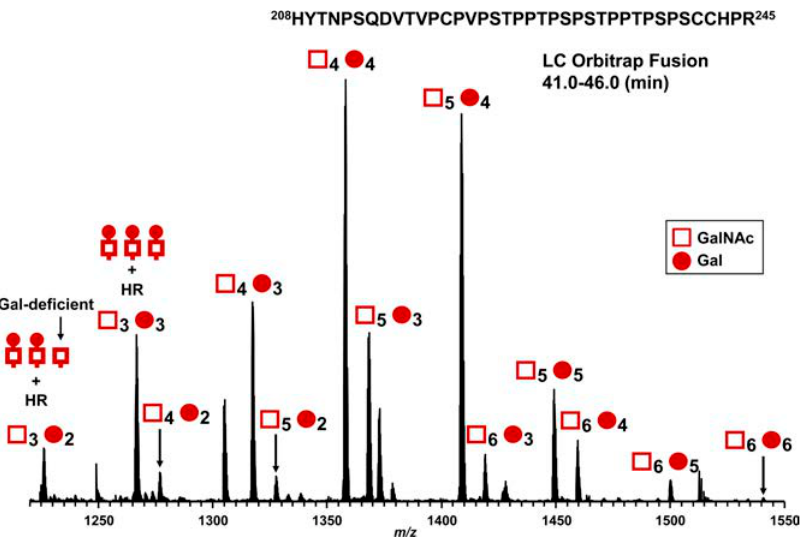
Figure 2 Mass spectra of IgA1 hinge region (HR) O -glycoforms. The number of O -glycan chains was assigned based on the masses of the amino acid sequence (His 208 –Arg 245 ), GalNAc (open square), and Gal (close circle). Individual peaks were assigned to glycopeptides. The numbers of GalNAc and Gal molecules are shown above these individual peaks. Glycopeptides were ionized as 4+-charged ions. The number of O -glycan chains attached in the HR corresponds with the number of GalNAc residues. For example, the HR with GalNAc3Gal2 has two disaccharides and one GalNAc monosaccharide. The HR with GalNAc3Gal3 has three disaccharides. Three to six O -glycan chains with zero to three GalNAc molecules as monosaccharides are attached to the HR.